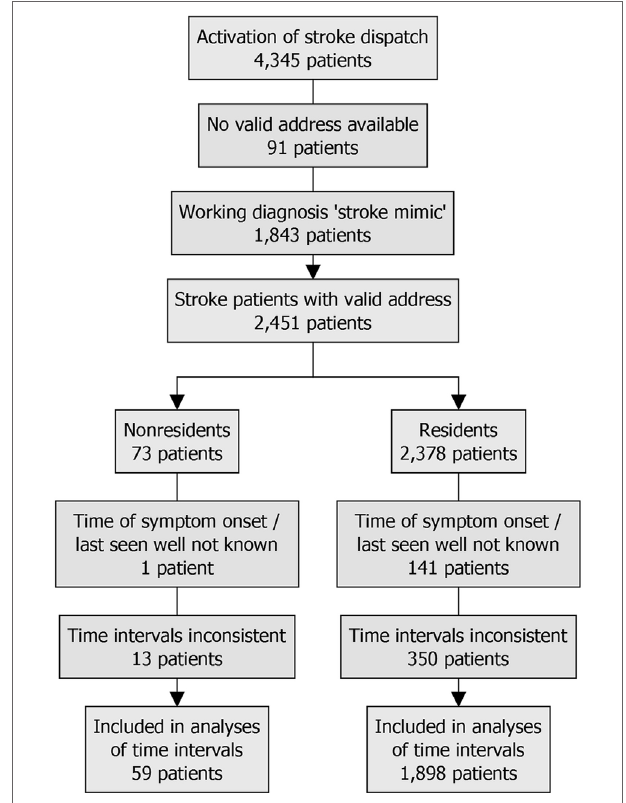
FigUre 1 | Flowchart.